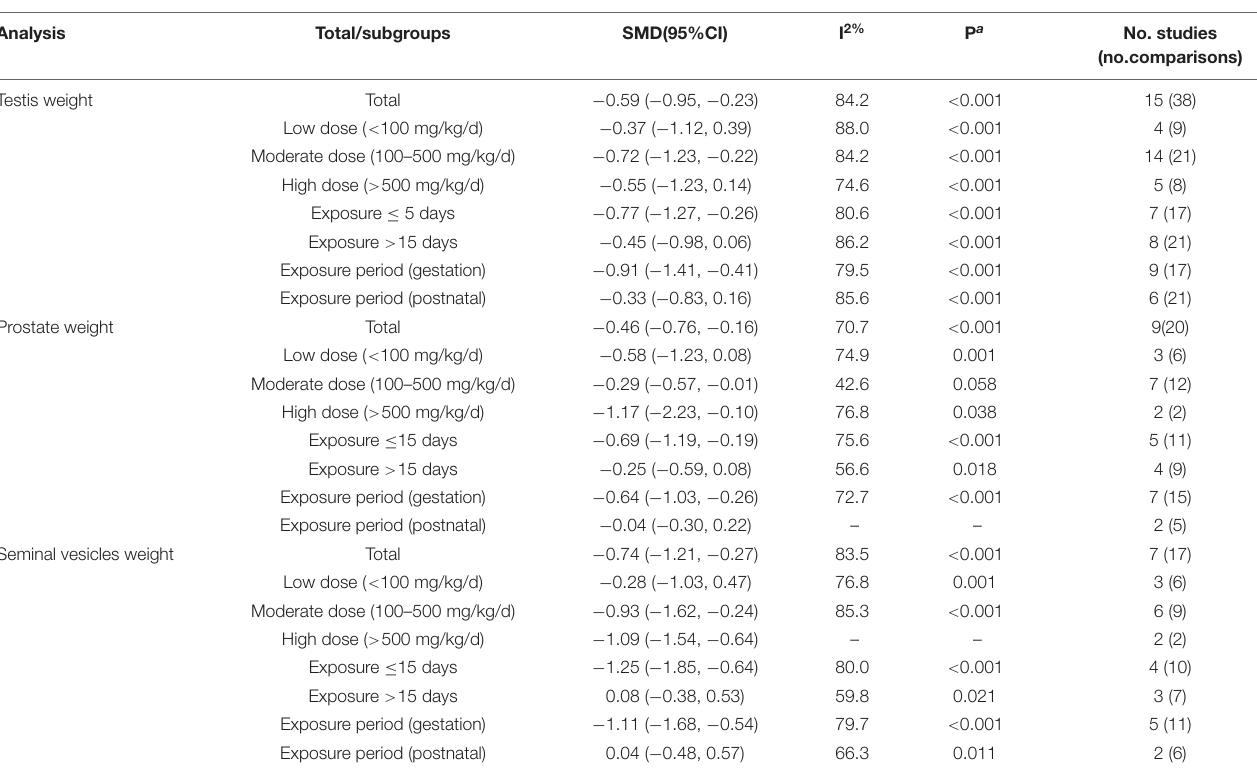
TABLE 3 | The result of meta-analysis in organ